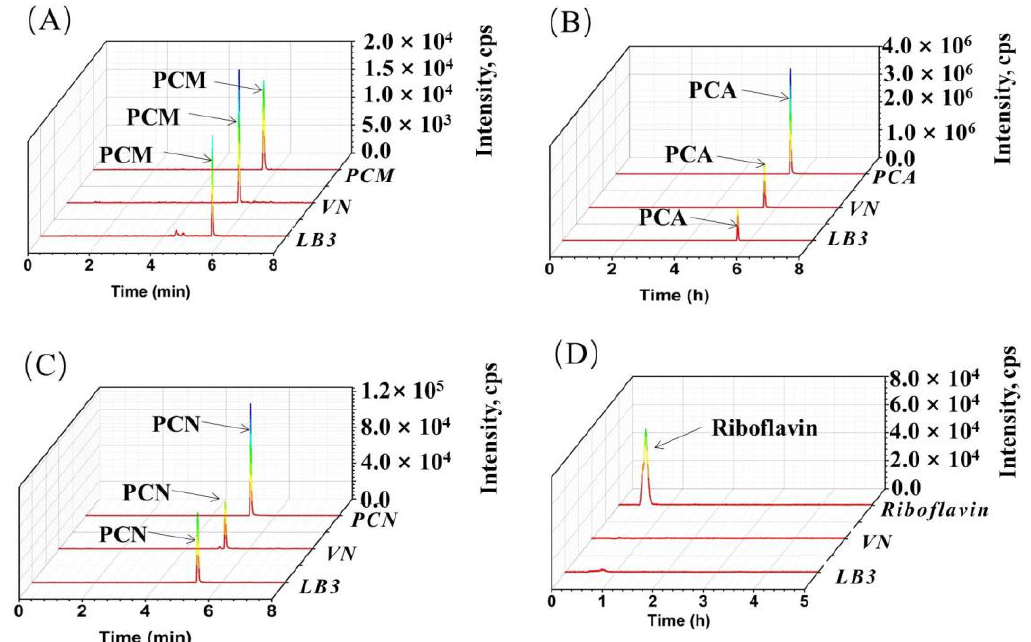
Figure 6. LC-MS chromatograms (extracted ion chromatograms in positive mode) of PCM ( A ), PCA ( B ), PHZ ( C ), and riboflavin ( D ) in LB3 MFC and VN MFC media. Retention time for the PCA, PCM, HPZ, and riboflavin are 5.61, 5.23, 5.59, and 0.54 min, respectively. PCA, phenazine-1-carboxylic acid; PCM, phenazine-1-carboxamide; HPZ, 1-hydroxyphenazine; VN, VN medium; LB, LB medium.